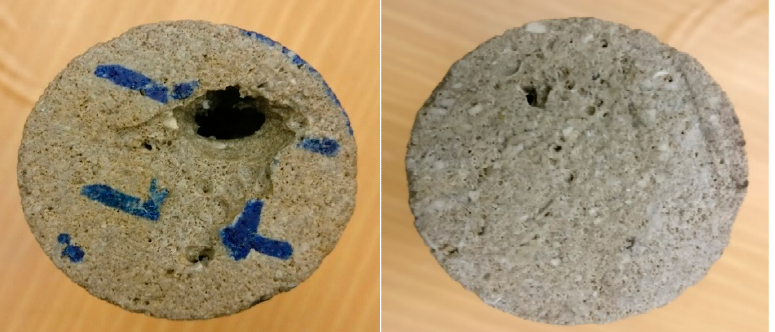
Figure 10. Images for the core inlet ( left ) and outlet ( right ), for the low-permeability sample after alternating treatment.